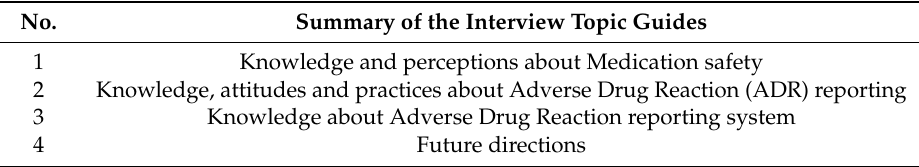
Table 1. Summary of the topic guide for the semi-structured interview.